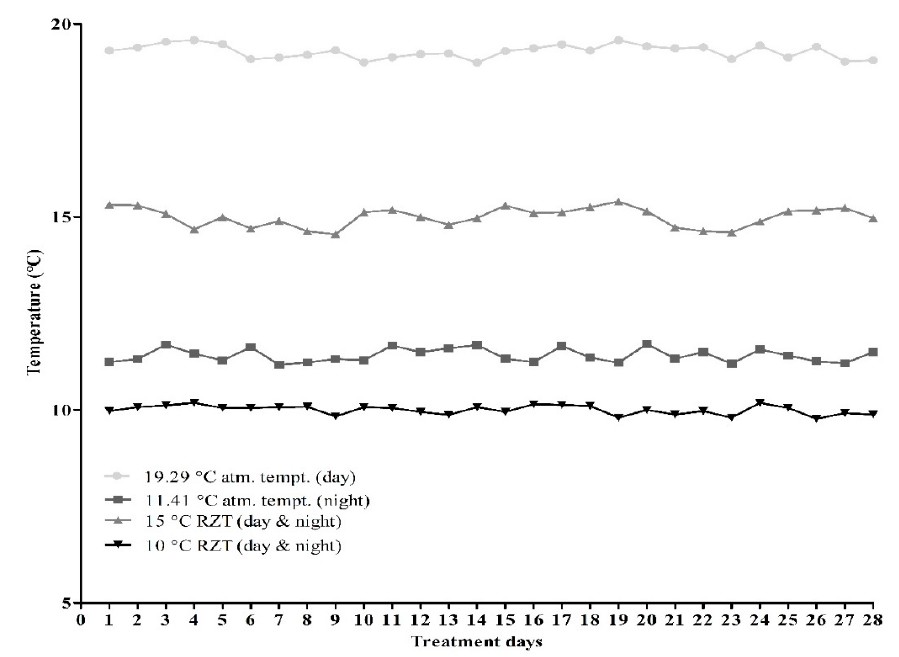
Figure 1. Lettuce growing atmosphere temperature (19.29/11.41, day/night) and treated root zone temperature (RZT 15/10, day and night) for 28 days in a deep flow technique (DFT) system during growth and development. Note: 18 th January to 14 th February 2018.